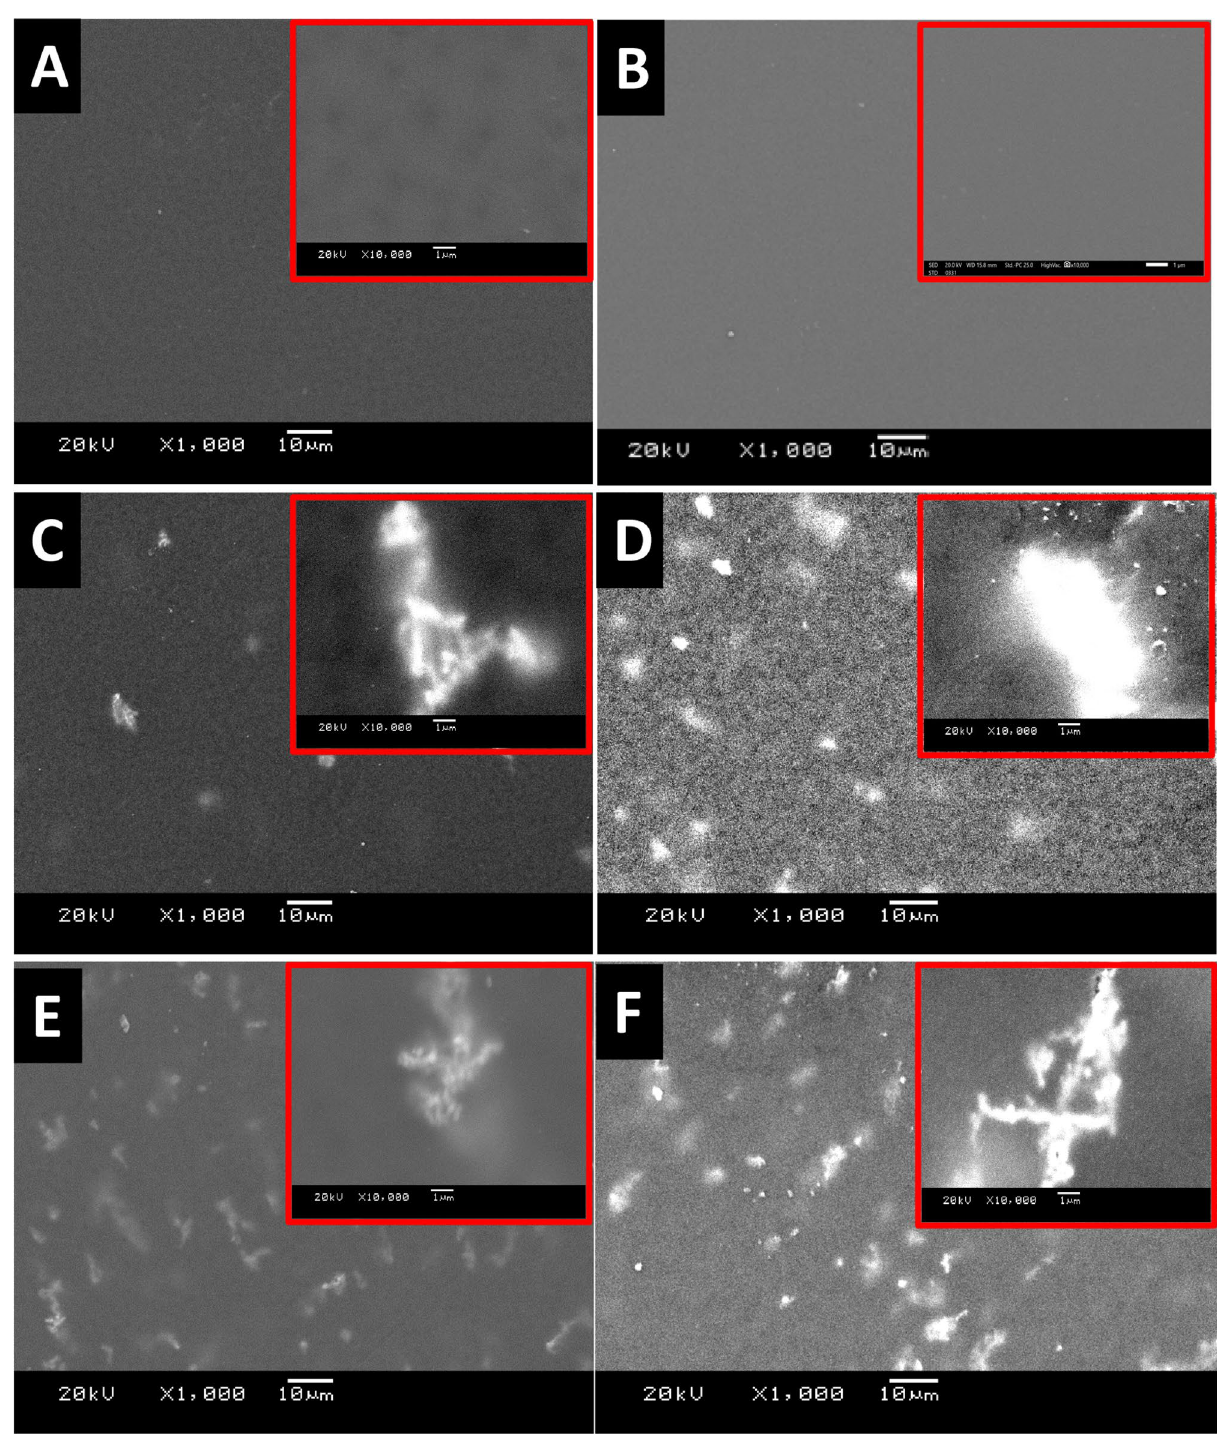
Figure 4. SEM images of the blank PES and mixed matrix PES membranes that were prepared using 1 NMP: 9 DMF solvents mix without ( A,C,E ) and with ( B,D,F ) 0.1 wt% of Lithium chloride. The blank PES membrane ( A,B ), the mixed matrix PES membranes using Fe 10 Ni 90 ( C,D ), and Fe 20 Ni 80 ( E,F ) alloys were imaged at × 1000 and × 10,000